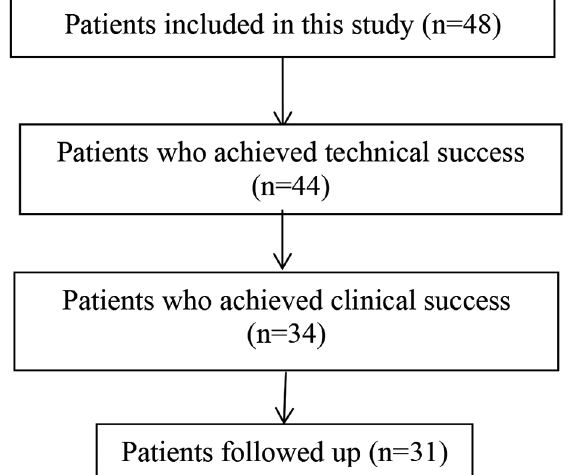
TABLE 1 Flow diagram of the patient selection